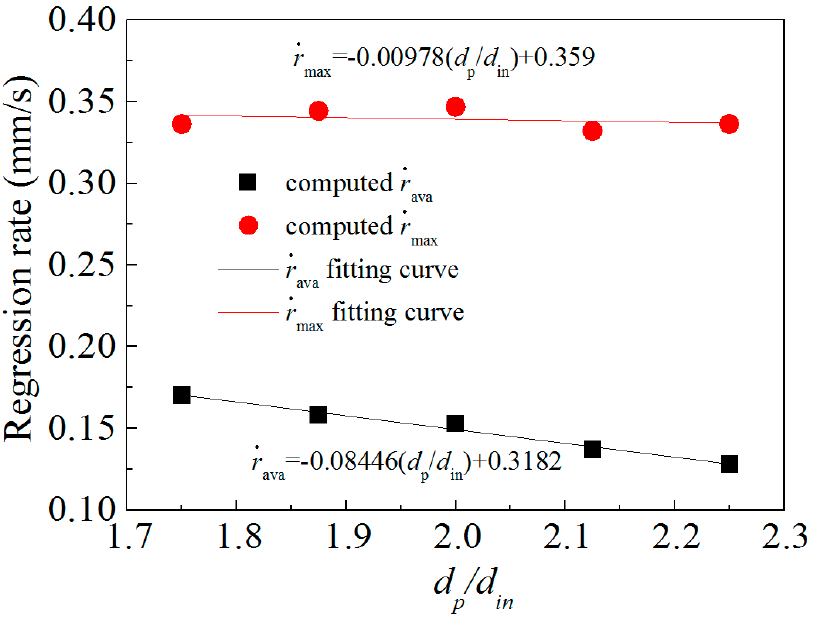
Figure 33. The regression rate for different sudden expansion ratio with d in fixed as constant.